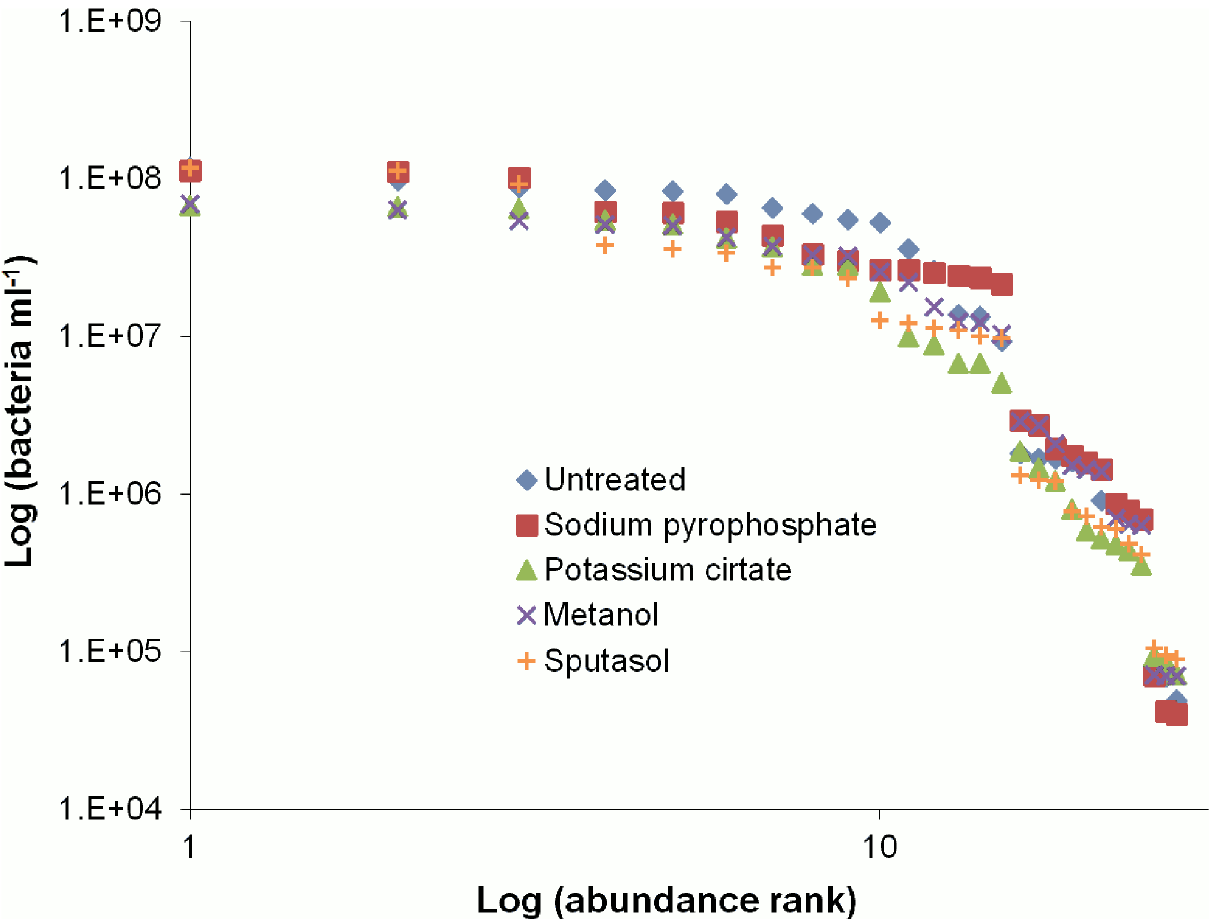
Fig 2. Rank abundance for each patient ’ s bacterial abundance for each sample treatment method, with triplicates shown. Three clear groups of patients with high, medium and low bacterial abundances are apparent. Differences in treatments used on the samples can be seen not to influence steps of bacterial abundance for